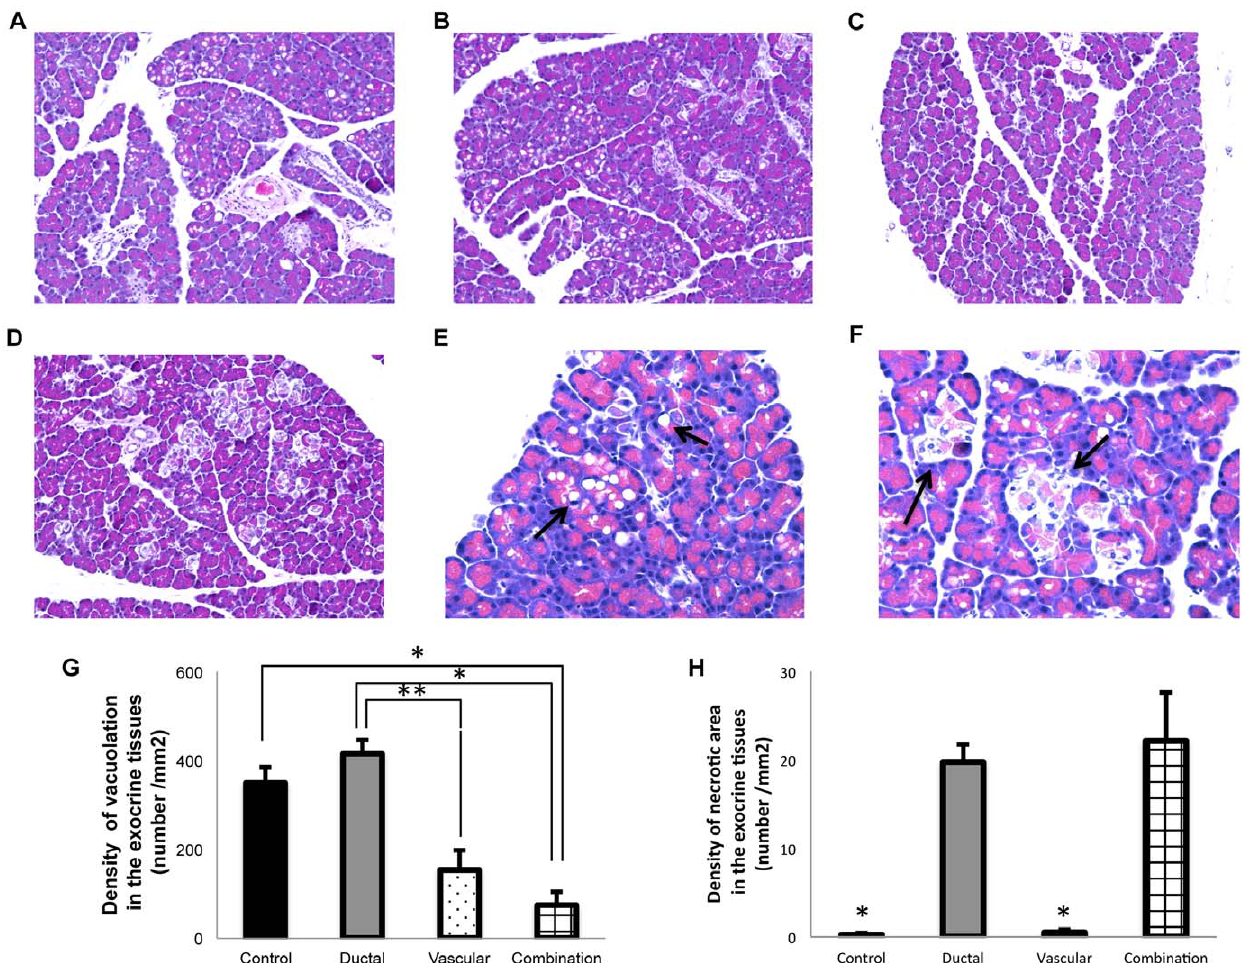
Figure 6. Evaluation of the vacuolation and necrotic area in the exocrine tissues. (A–D) Representative H&E images used to count the vacuolation and necrotic area in each group. Magnification 6 200. (A) Control group, (B) Ductal injection group, (C) Vascular perfusion group, (D) Combination group. (E) H&E stained examples of vacuolation are shown (arrow). Magnification 6 400. (F) H&E examples of necrotic areas in the exocrine tissues are shown (arrow). Magnification 6 400. (G) The density of vacuolation in the exocrine tissues (number/mm 2 ). The density of vacuolation in the exocrine tissues was significantly lower in the vascular and combination groups compared with the ductal group. The vacuolation density of the combination group was also significantly lower than that of the control group. The data show the means 6 SE. * P , 0.01 ** P , 0.05 (H) The density of the necrotic area in the exocrine tissues (number/mm 2 ). The densities of the control and the vascular groups were significantly lower than that in the other groups. * P ,